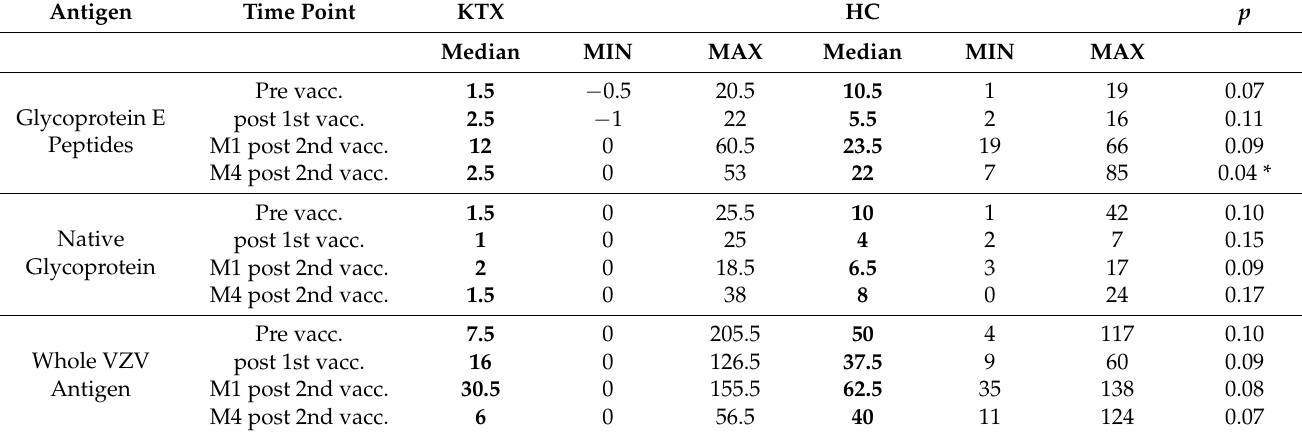
Table 3. Comparison of varicella–zoster virus (VZV)-specific ELISpot responses in 29 kidney trans- plant (KTX) recipients and four healthy controls